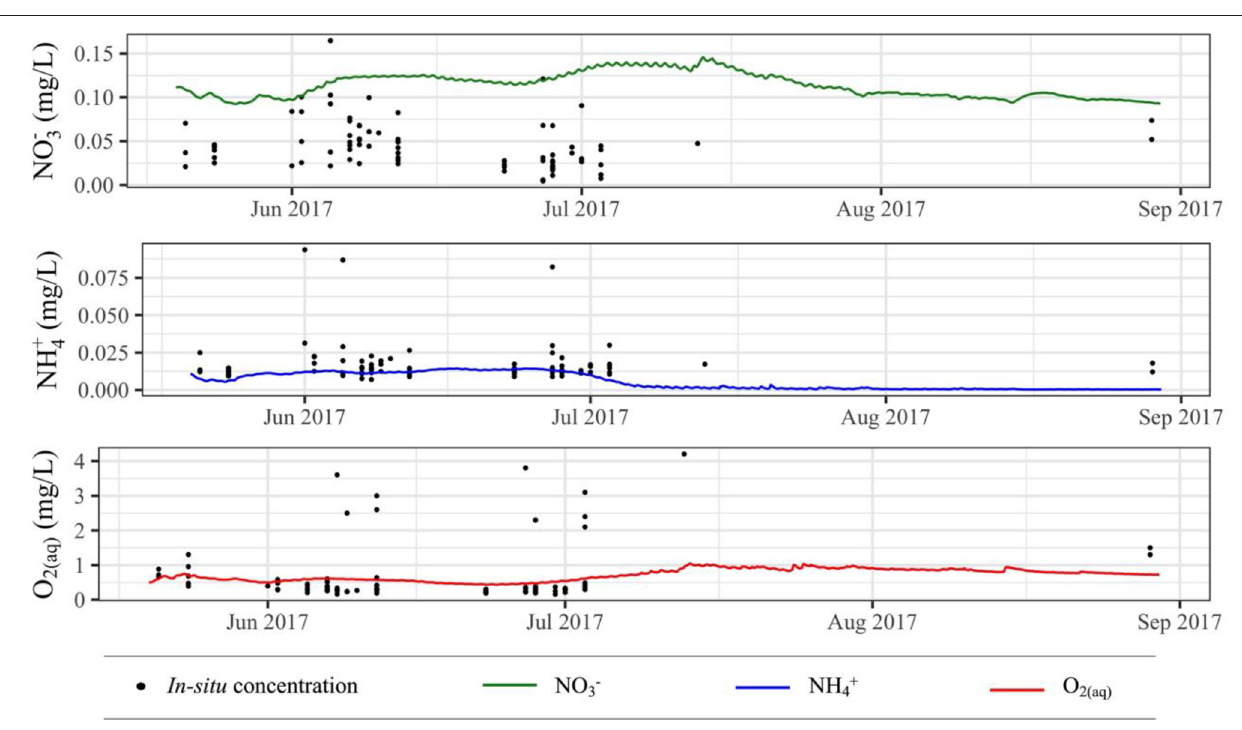
a surface flux event. Spikes in DNRA FR rates were determined using a threshold value of 0.125 mmol N m − 2 d − 1 ; similar percentages were obtained using various threshold